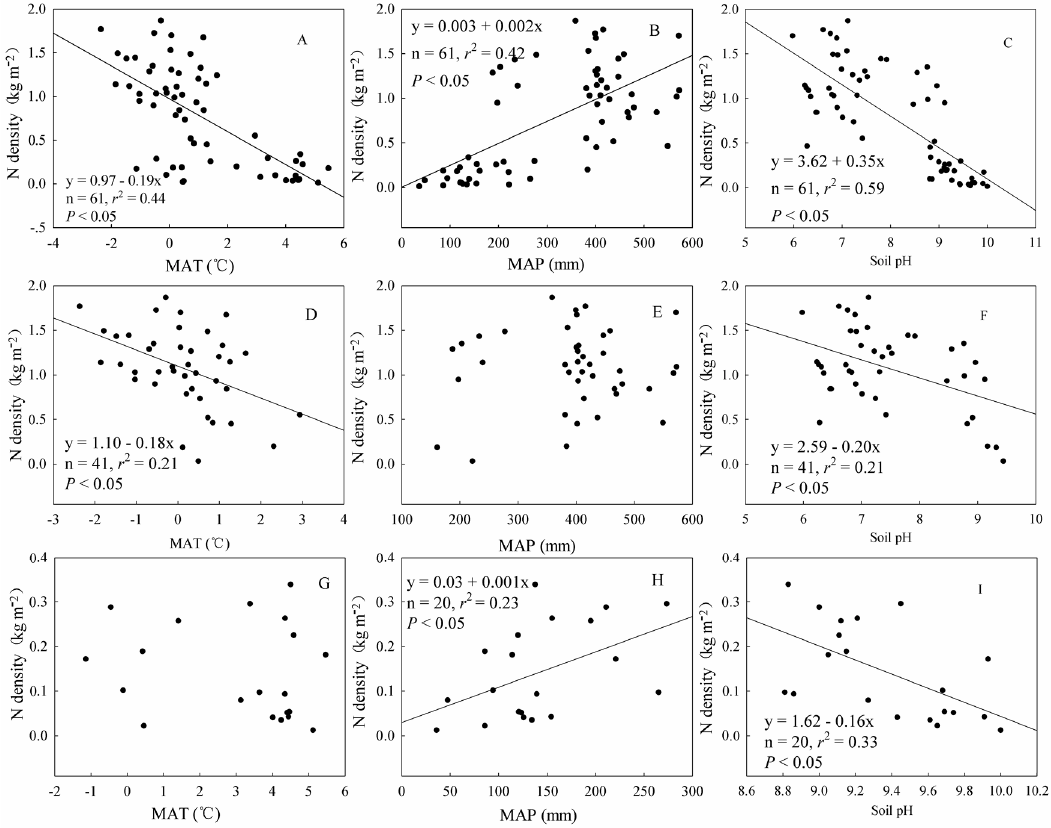
Figure 4. Relationships between soil N density and the mean annual precipitation (MAP), mean annual temperature (MAT), and soil pH across the Tibetan Plateau. ( A – C ) All shrublands; ( D – F ) alpine shrublands; and ( G – I ) desert